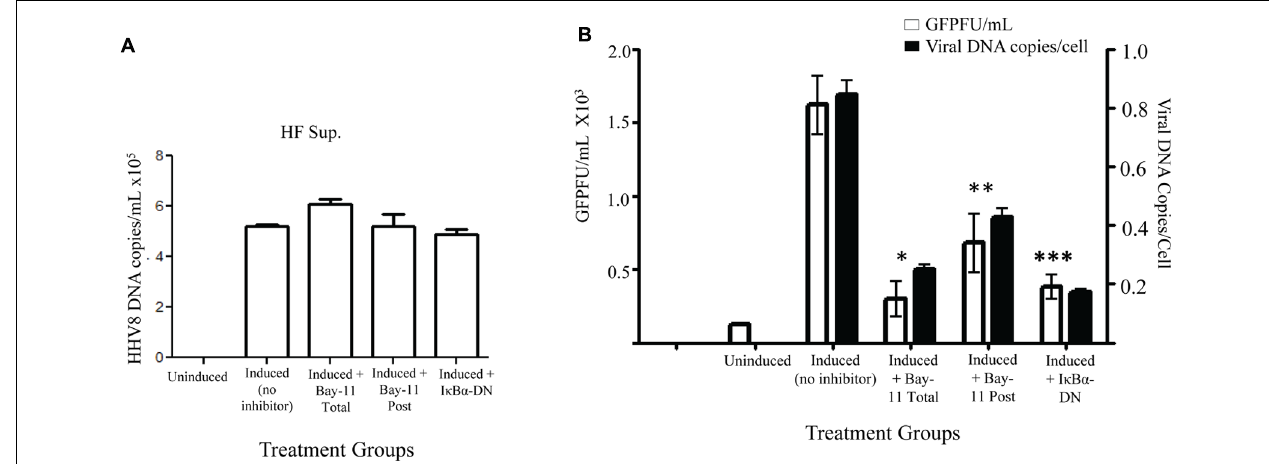
for the Uninduced sample. When indicated, cells were either mock treated (No inhibitor, DMSO only), cotransfected with I κ B α -DN or treated with Bay11-7082 prior to induction (Total) or at time of induction (Post). Viral DNA was quantitated by real time PCR ( (cid:2) ). Cell number was calculated by β -globin copy number. Supernatants were used in a viral titer assay on 293 cells to enumerate GFP forming units ( (cid:3) ).Samples were assayed in triplicate and are representative of three experiments. For all experiments, 1 x 10 5 cells were used. P values as follow for GFPF/mL as compared to induction only: * p < 0.043, ** p < 0.0541, and *** p < 0.0349. For viral DNA copies/cell as compared to induction only: * p < 0.0489, ** p < 0.0718, and *** p <